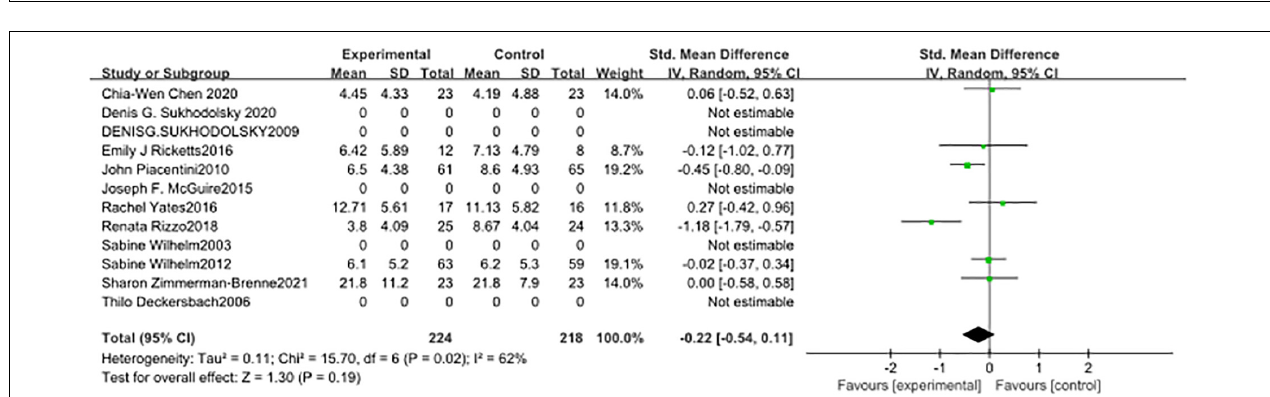
FIGURE 5 | Forest plot of the effect of cognitive-behavioral therapy (CBT) treatment groups vs. control groups on the motor tic score.